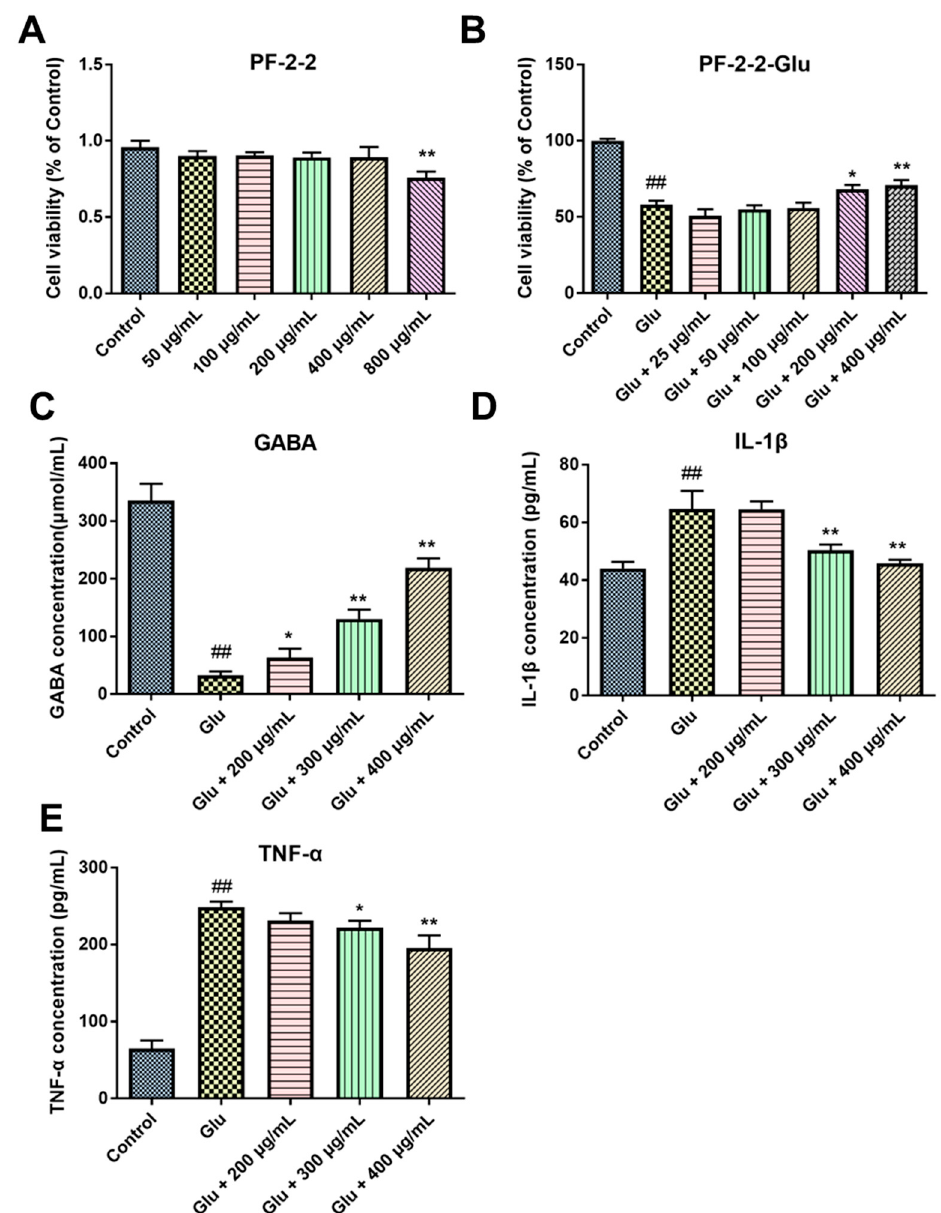
Figure 6. Effects of PF-2-2 on the cell viability of normal ( A ) and Glu-injured ( B ) PC12 cells. Effects of PF-2-2 on levels of GABA ( C ), IL-1 β ( D ), and TNF- α ( E ) in Glu-injured PC12 cells. ## p < 0.01 vs. the control group, * p < 0.05 vs. the Glu-treated group, ** p < 0.01 vs. the Glu-treated group.